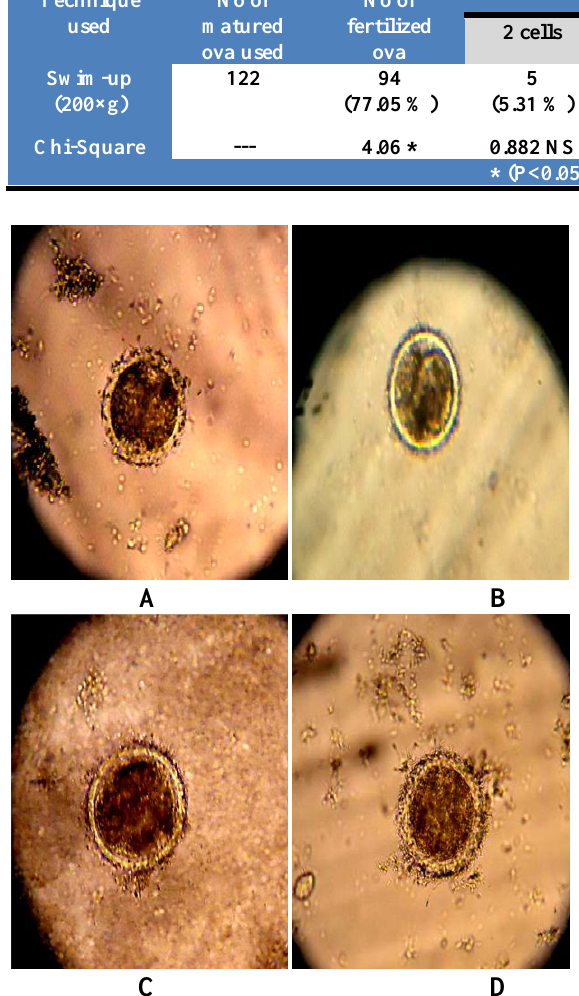
Figure, 1: Different stages of local goat embryos produced in vitro using caudal spermatozoa; 2 cell stage (A), 4 cell stage (B), 8 cell stage (C) and 16 cell stage (D), (× 40).